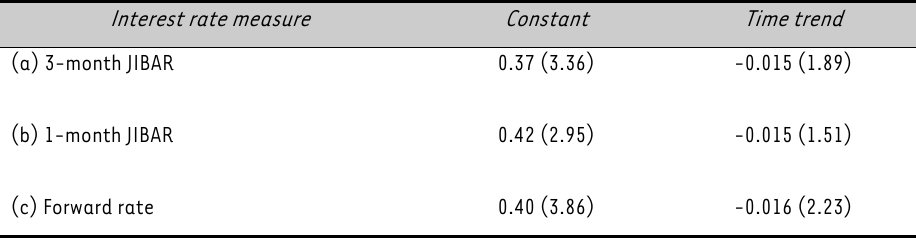
TABLE 4: Surprise Component of MPC Announcements, 2003-2006 (based on daily data)